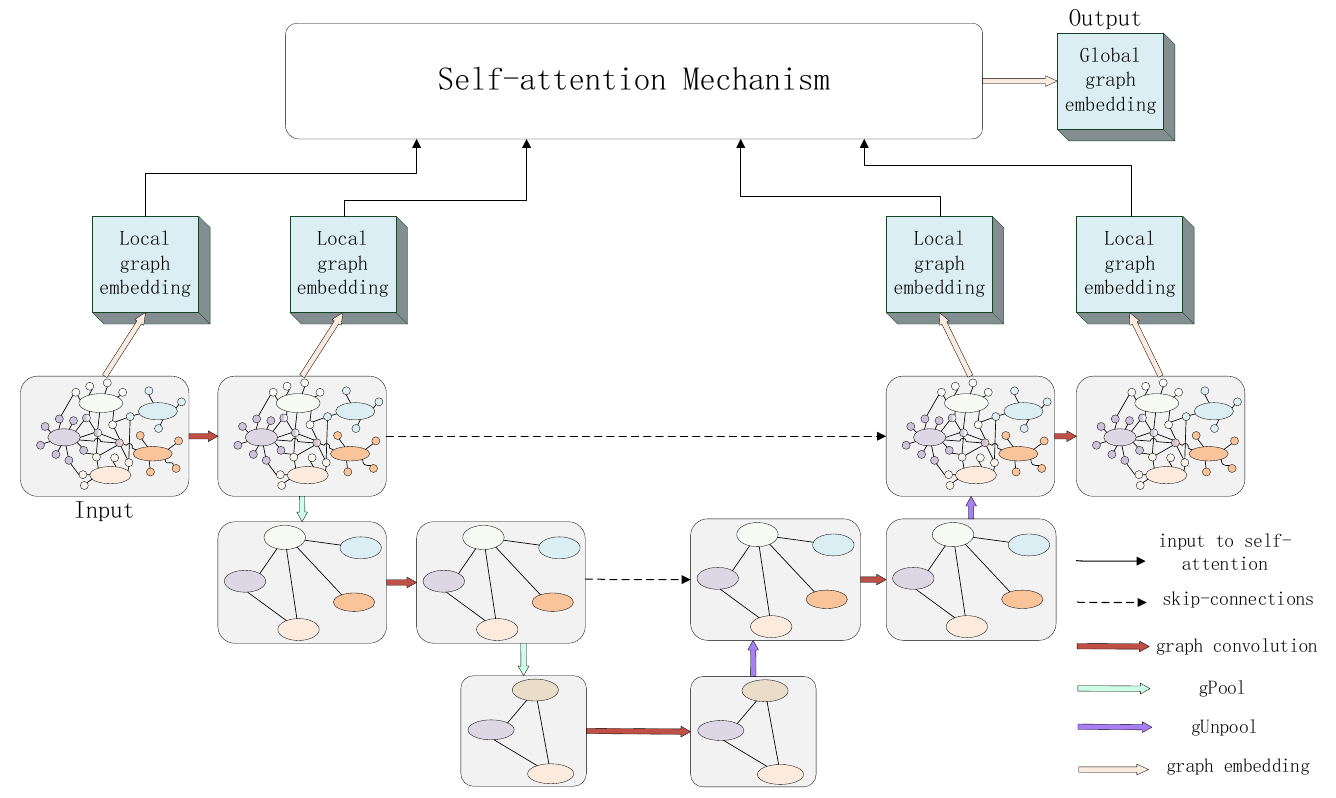
Figure 2. Schematic diagram of improved graph pooling method based on graph u-net and self- attention mechanism.